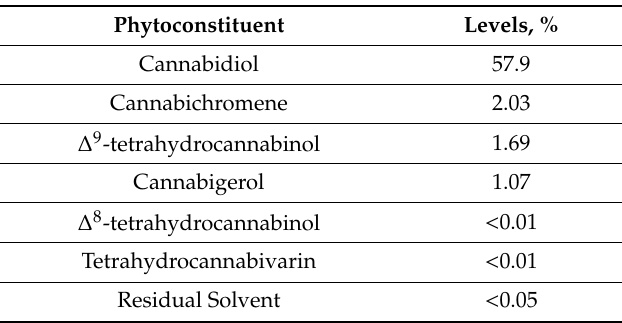
Table 1. Phytocannabinoid characterization of cannabidiol-rich cannabis extract